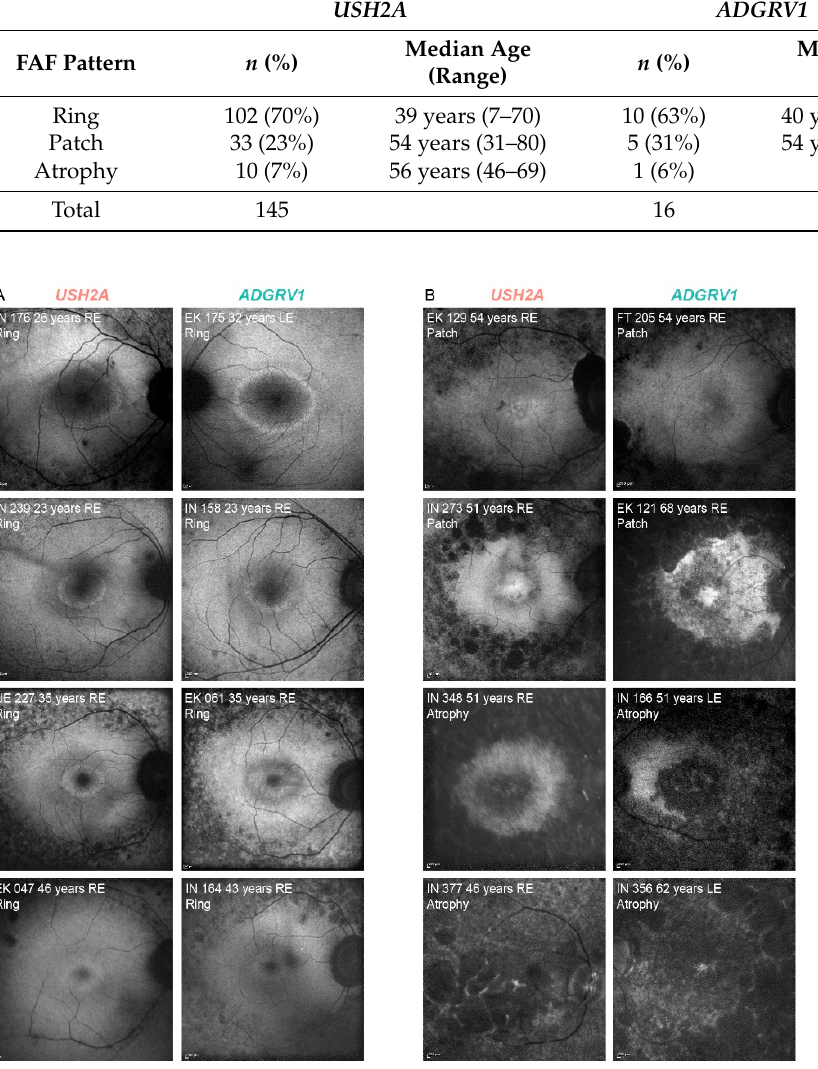
Figure 3. Representative FAF images of USH2A and ADGRV1 patients. ( A ). hyperautofluorescent rings with preserved central retina. ( B ). advanced disease—hyperautofluorescent patch and atrophy. The patient’s ID, age and FAF pattern is stated in the top left corner of each image. The affected gene is stated above each column. Note that almost identical patterns were found in both groups. Red color represents USH2A patients and green color represents ADGRV1 patients. Table 2. Distribution of different FAF patterns in USH2A and ADGRV1 patient groups.